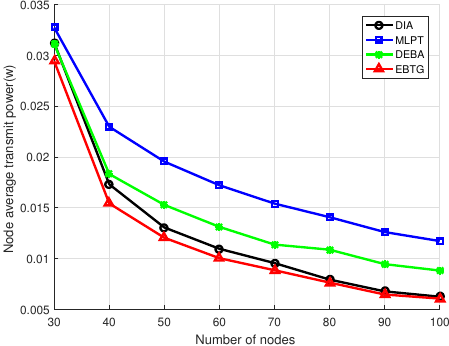
Figure 5. Node average transmit